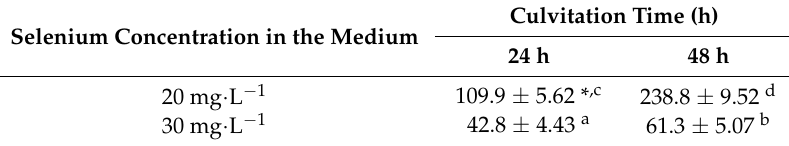
Table 1. The content of selenomethionine in Candida utilis ATCC 9950 yeast cell biomass. Selenium Concentration in the Medium